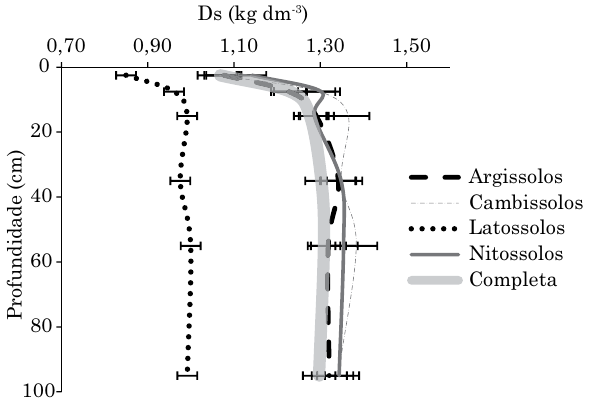
Figura 3. densidade média ao longo de 1 m de profundidade, por ordem de